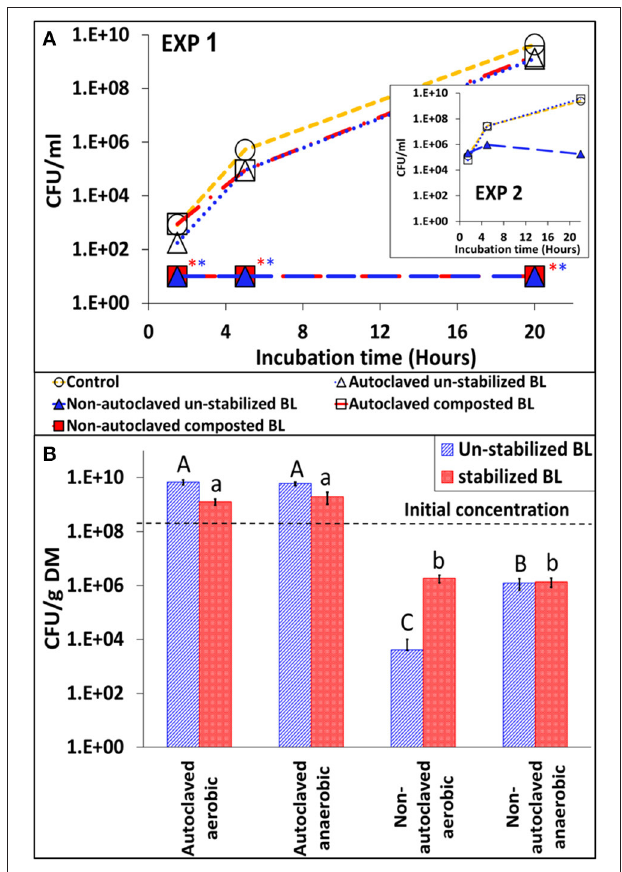
FIGURE 6 | The efect of heat inactivation of indigenous microbial populations in broiler litter (BL) on S. Infantis multiplication and persistance. (A) Growth of Salmonella in nutrient broth suspension of autoclaved or non-autoclaved BL (un-stabilized and composted BL; initial Salmonella concentration ca. 2 log CFU ml − 1 ). The inset figure shows the results of a similar experiment conducted with BL from another farm and at higher initial Salmonella concentration ( ca. 4 log CFU ml − 1 ). *Values below the detection limit without enrichment (10 CFU ml − 1 ). (B) Persistence of Salmonella in the un-stabilized and stabilized BL itself, which were artificially contaminated with the pathogen and incubated for 11 days. Error bars represent the standard deviations of triplicate tubes. Letters denote significant differences between treatments by the end of the incubation period (log-transformed CFU values; Tukey-Kramer HSD; P ≤ 0.05). DM, dry matter.